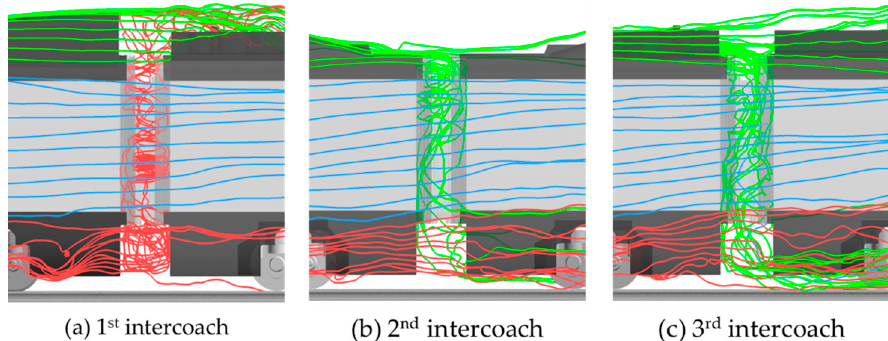
Figure 14. Streamlines near intercoach space: red: from bogie and bogie fairing; blue: from sidewall; green: from roof.